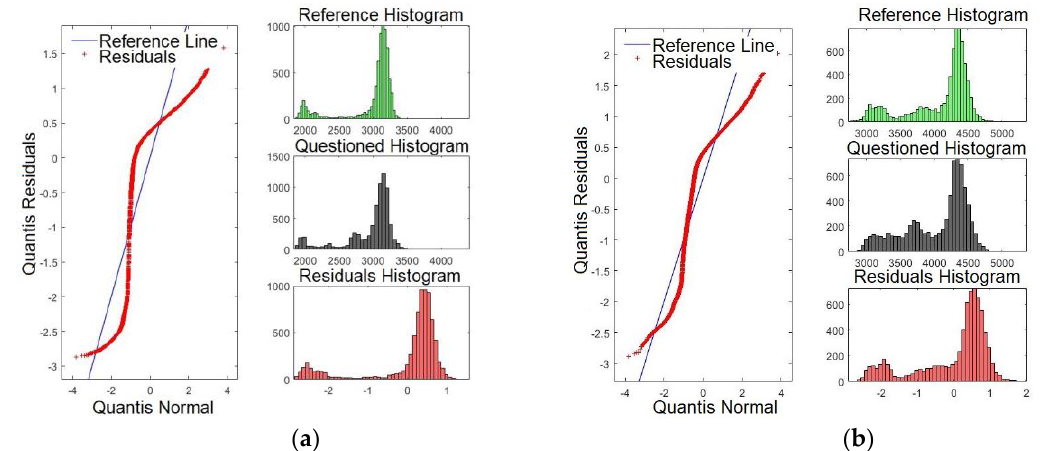
Figure 8. Q-Q plot of the formants comparing the confronted with the reference audios: (a) formant F2 and (b) formant F3 .